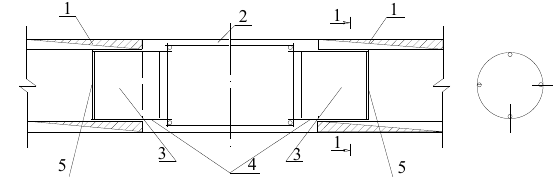
Fig. 2. Improved connection of circular hollow-core slabs with a monolithic girder in a precast-cast-in-place floor: